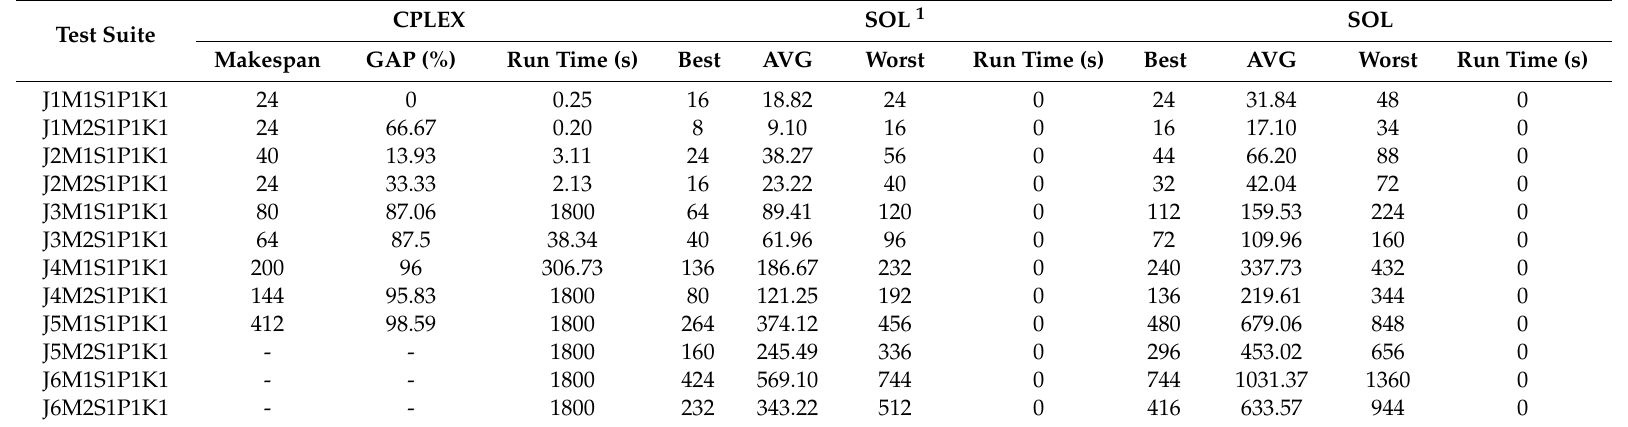
Table 6. Simulation results of CPLEX and the 2-approximation algorithm with one-job-overfull batches and a feasible